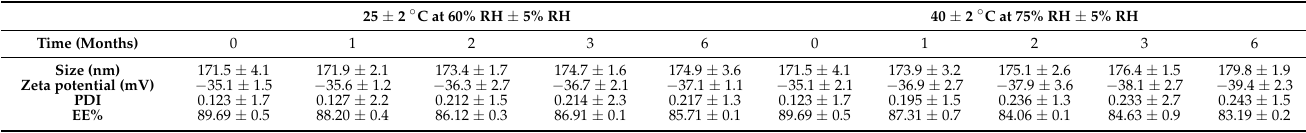
Table 5. Stability study done over a period of 6